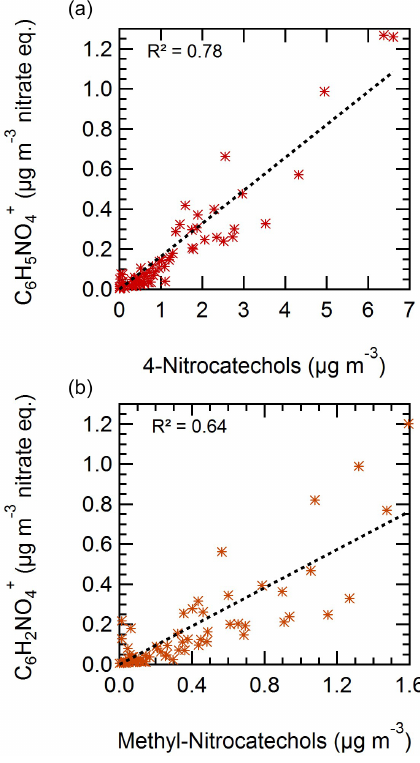
Figure 9. HR-ToF-AMS measurements against TAG-AMS mea- surements. C 6 H 5 NO + ( m/z 155.022) vs. 4-nitrocatechol (a) , 4 and C 6 H 2 NO + ( m/z 151.098) vs. alkylated nitrocatechols (3- 4 methyl-5-nitrocatechol and 4-methyl-5-nitrocatechol) (b) , during the aging of biomass burning emissions. Intensities of C 6 H 5 NO + 4 ( m/z 155.022) and C 6 H 2 NO + ( m/z 151.098) from the HR-ToF- 4 AMS data are expressed here in µgm − 3 nitrate equivalent, which reflects the peak intensities and not an actual concentration. A ded- icated calibration of the HR-ToF-AMS is